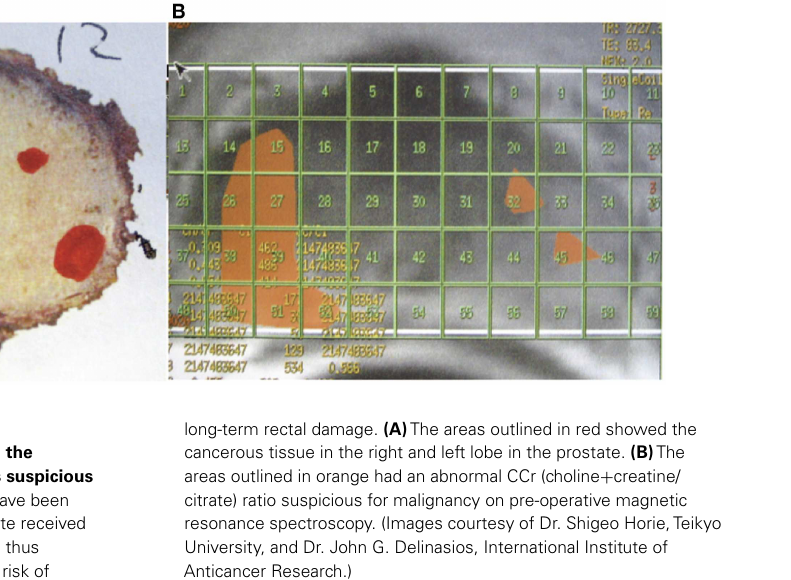
FIGURE 3 |This patient had a radical prostatectomy demonstrating two intra-prostatic adenocarcinoma in the pre-operative magnetic resonance spectroscopy areas suspicious for malignancy .These two gross tumor volumes could have been treated to a higher radiation dose (81Gy) while the prostate received only 78Gy with the image-guided radiotherapy technique, thus improving the chance for local control and decreasing the risk of